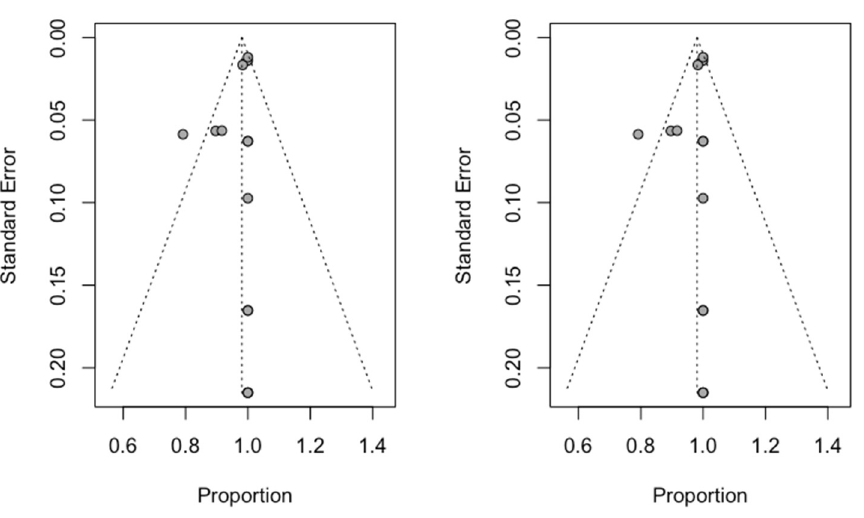
Figure 6. Initial Funnel plot and after Trim and Fill adjustment.